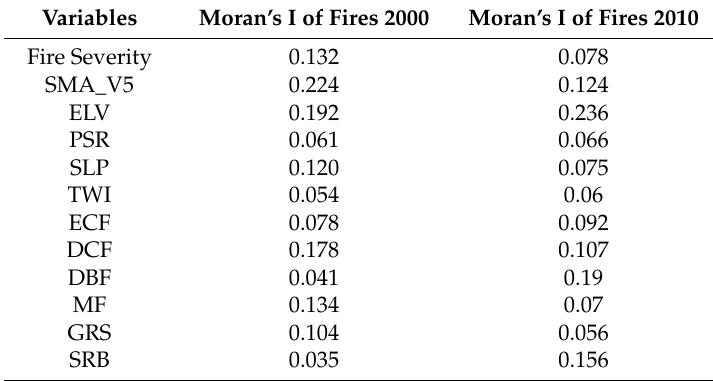
Table A1. The Moran’s I for examining spatial autocorrelation of fire severity and explanatory variables. Variable abbreviations were described in Table 2.